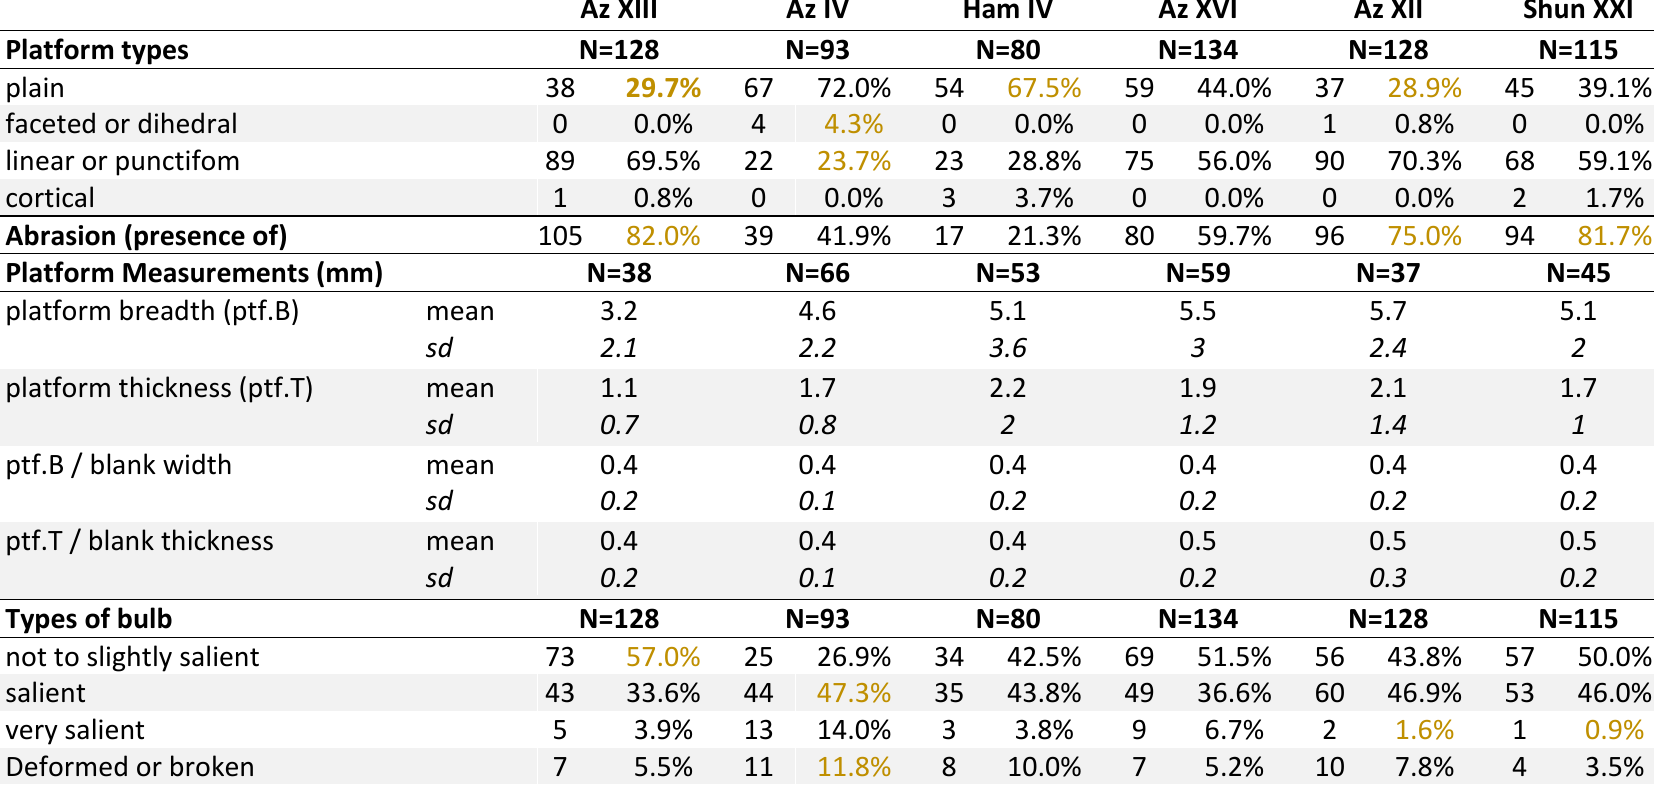
Table 9. Main characteristics of the proximal parts of elongated blanks. In bold: values with the highest residuals of the Chi2 test. Az - Azariq; Shun - Shunera; Ham -